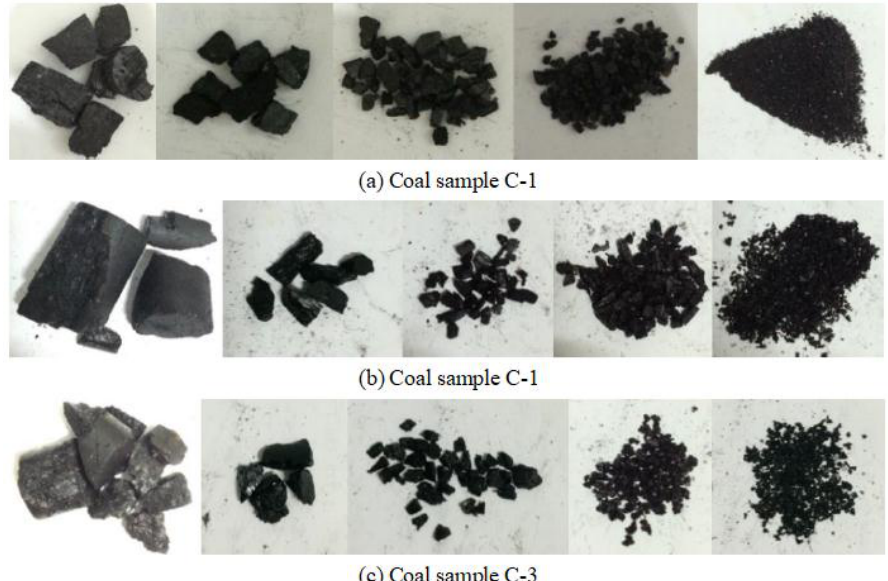
Figure 14. PSD of coal fragments under different mining paths (I. >15 mm; II. 10 – 15 mm; III. 5 – 10 mm; IV. 2 – 5 mm; V. <2 mm). Table 2. PSD and fractal dimensions measured in the experiments.